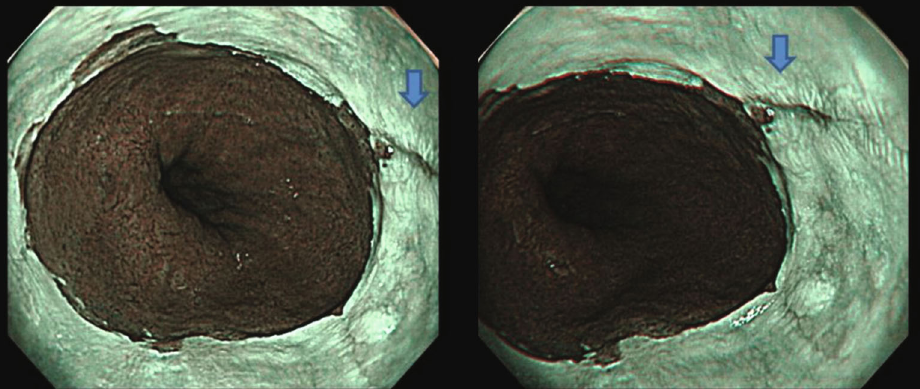
Figure 2: Example image fi le of nonmagni fi ed narrow-band imaging used in this study (same patient as Figure 1). All 8 endoscopists judged the area marked with a blue arrow to be a mucosal break.